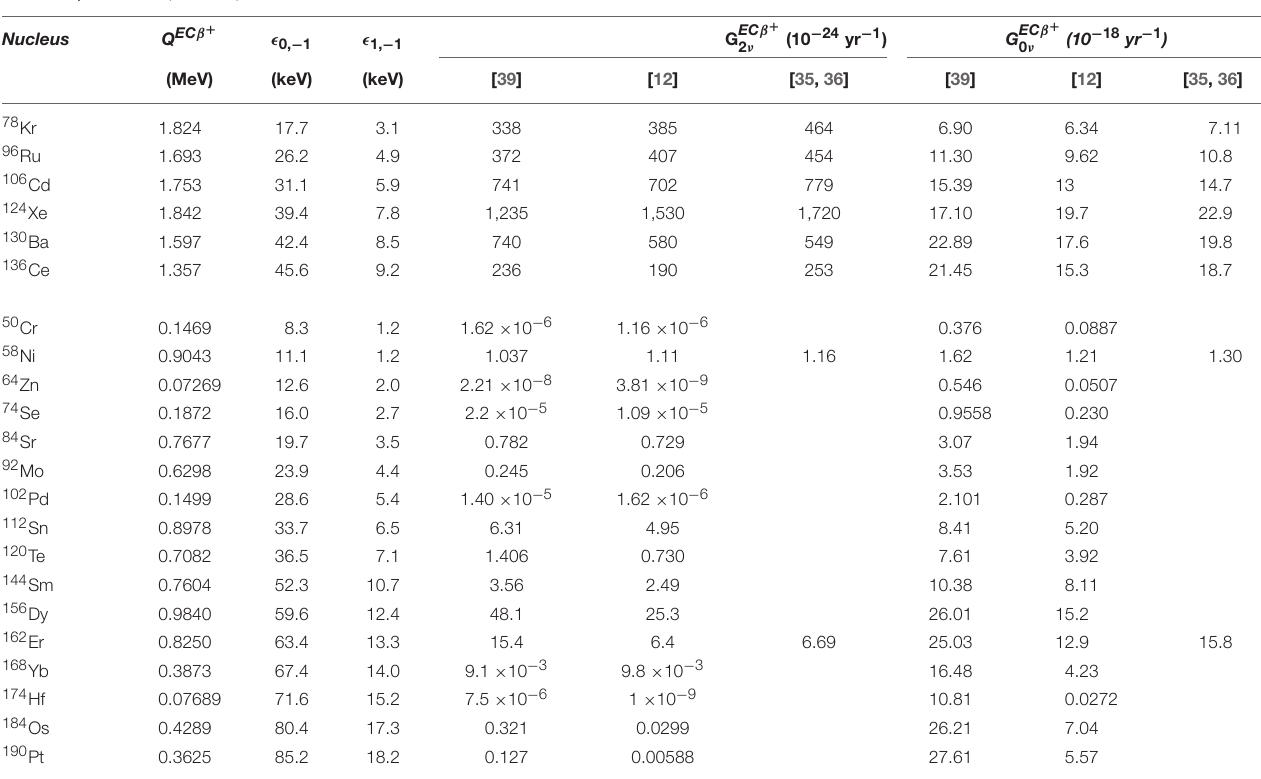
TABLE 6 | PSF for EC β + decay